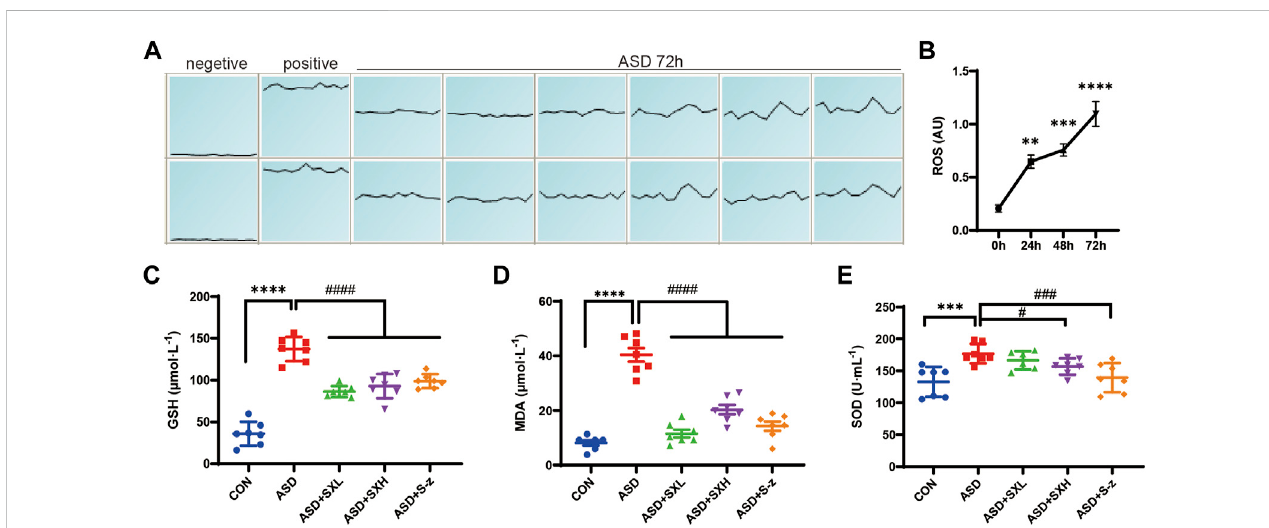
FIGURE 3 SXalleviatesASD-inducedoxidativestressinthemouseserum. (A)(A) .ROS fl uorescenceintensityofbloodcellsafter72 hofASD,waveformsareimagesobtained in “ multi-point scanning ” mode for each well, with the top and bottom wells being multiple wells. The average of each well was taken for statistical analysis. Positive control Rosup concentration was 100 μ M. (B) . Fluorescence intensity before and after ASD was measured at 488 nm excitation wavelength and 535 nm emission wavelength,timepointbytimepoint(0,24,48,72 h). (B) ROSlevelsinthebloodcellsofASDgroupmiceat0,24,48,and72 h. (C) SerumGSHlevelsintheCON, ASD,ASD+SXL,ASD+SXH,andASD+S-zgroupsofmice. p < 0.0001,ASDvs.SXL,SXH,S-z. (D) SerumMDAlevelsintheCON,ASD,ASD+SXL,ASD+SXH,andASD + S-z groups of mice. p < 0.0001, ASD vs. SXL, SXH, S-z. (E) Total SOD activity in theserum of CON, ASD, ASD+ SXL, ASD + SXH, and ASD+ S-z groupsof mice. p < 0.05, ASD vs. SXH; p < 0.001 ASD vs. S-z. The data are represented as means ± SEM. n = 7 each group. Statistical signi fi cance was determined based on one-way ANOVA; **** p < 0.0001, *** p < 0.001, ** p < 0.01 vs. CON group; #### p < 0.0001, ### p < 0.001, ## p < 0.01, # p < 0.05 vs. ASD